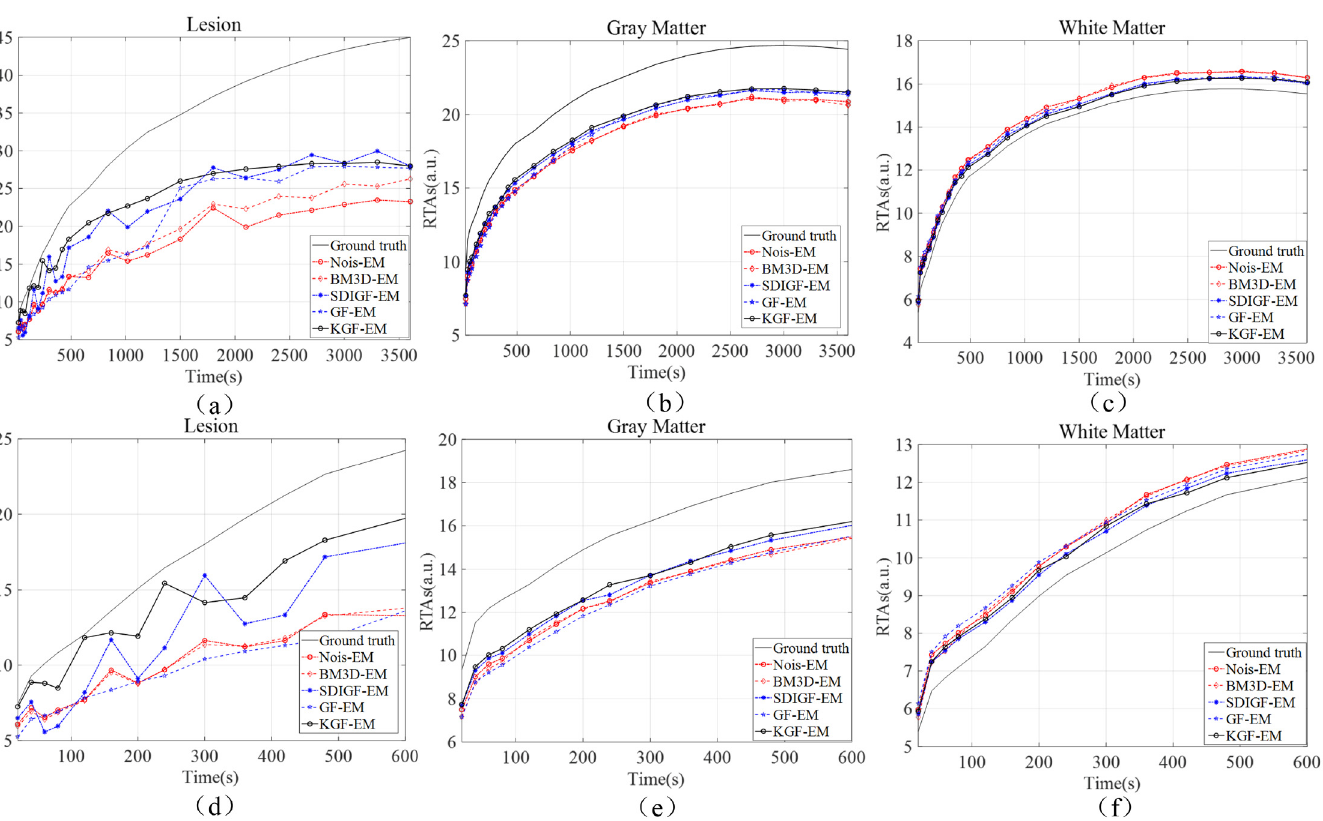
Fig 6. RTAs and local TACs of MLEM reconstructed image frames from the sinograms denoised by different methods. (a) Lesion, (b) gray matter, and (c) white matter over 0–3600 seconds. (d) Lesion, (e) gray matter, and (f) white matter over 0–600 seconds.